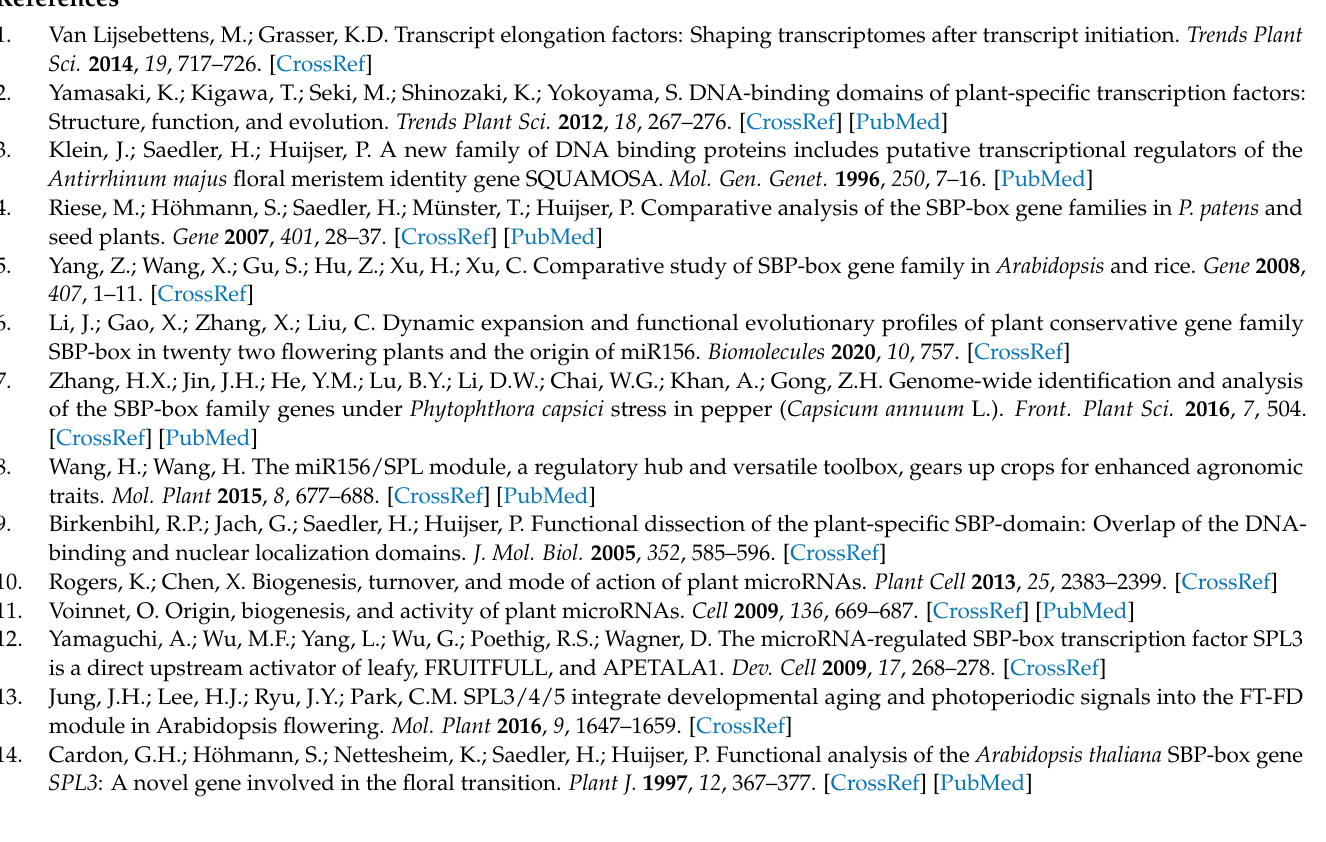
Table S1: The duplications of pepper SBP genes, Table S2: The information of predicted miR156 genes in pepper genome, Table S3: The distribution of miR156 binding sites in pepper SBP